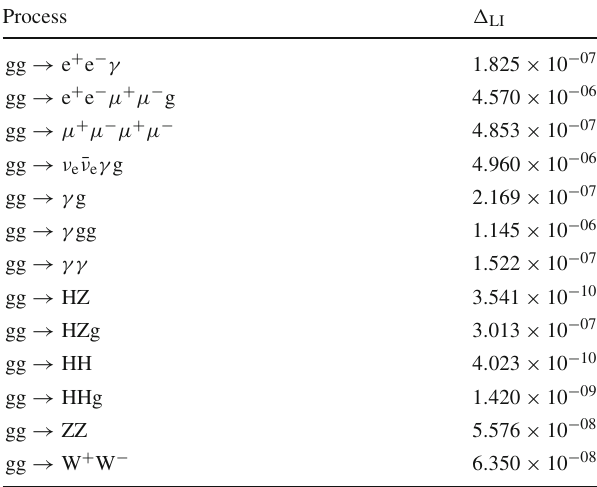
Table 2 Average relative deviations (cid:5) LI between Sherpa + Recola and Sherpa +O pen L oops for the matrix element squared evaluated for 1000 phase-space points for QCD loop-induced processes. The average relative deviations are calculated by averaging the logarithms of the relative deviations between the two results for the considered phase- space points Process (cid:5)